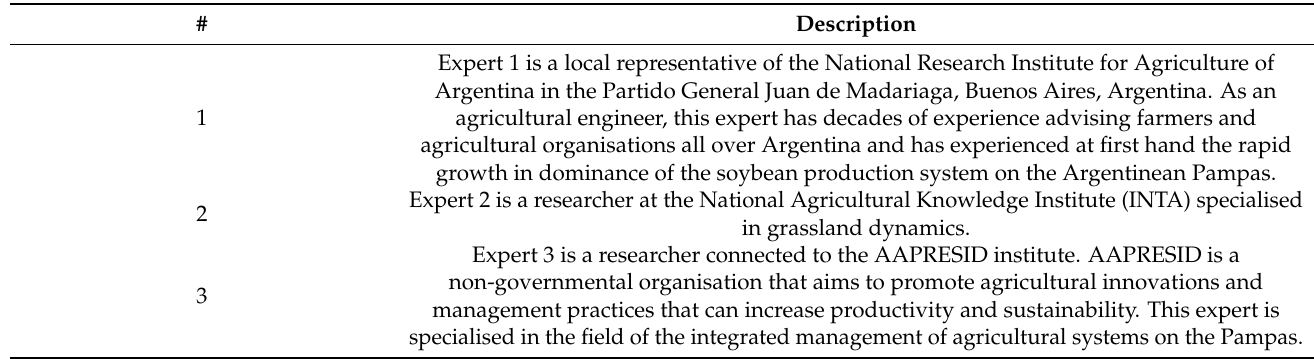
Table A3. Characteristics of the adaptation experts interviewed in this